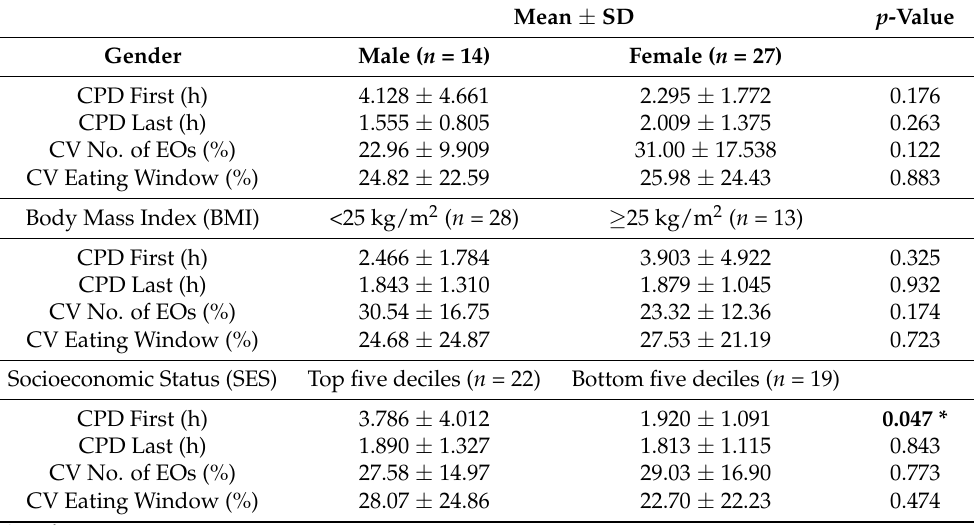
Table 5. Associations between day-to-day variability and demographic variables.